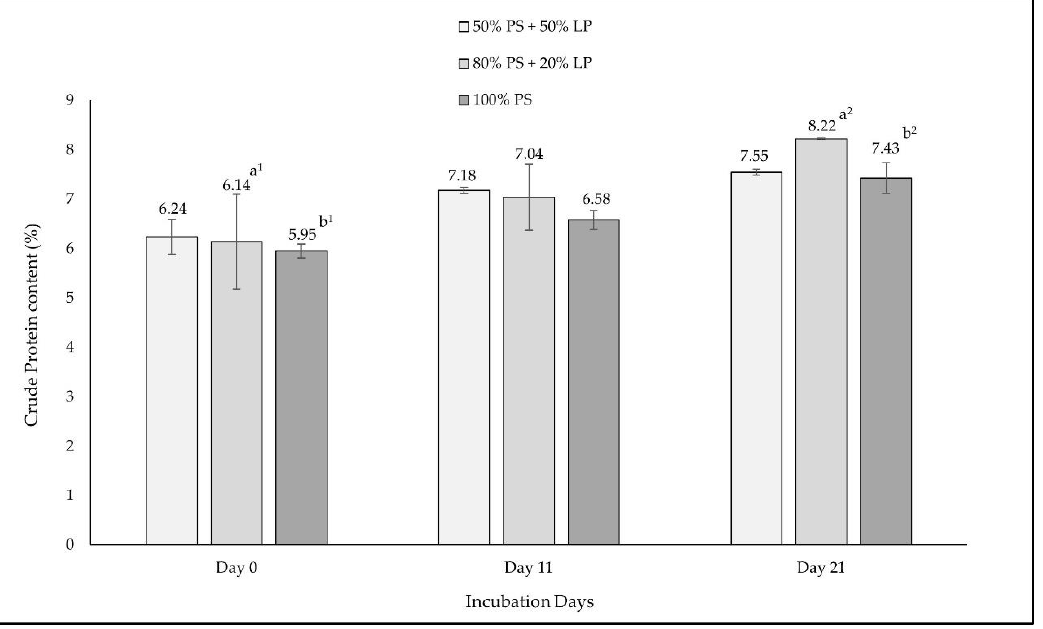
Figure 3. Evaluation of crude protein content (%) for PS and its mixtures with LPs. Statistical anal- ysis was performed for each substrate individually between Day 0 and Day 21. Different super- scripts between the same letters indicate statistical significance ( p ≤ 0.05).